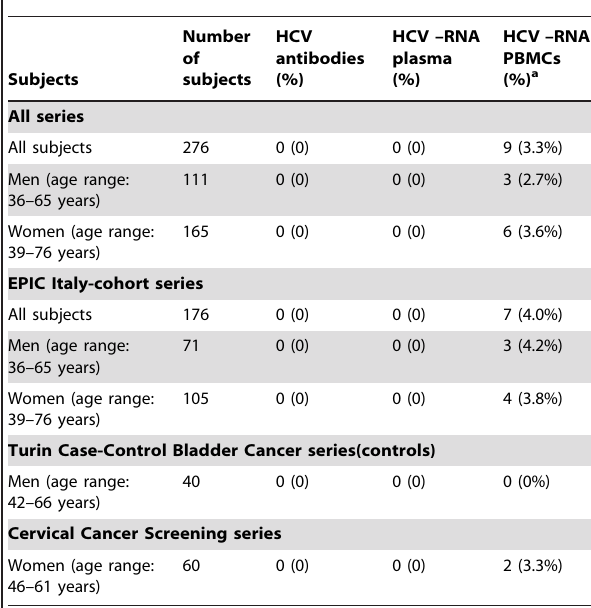
Table 1. HCV detection in three series of